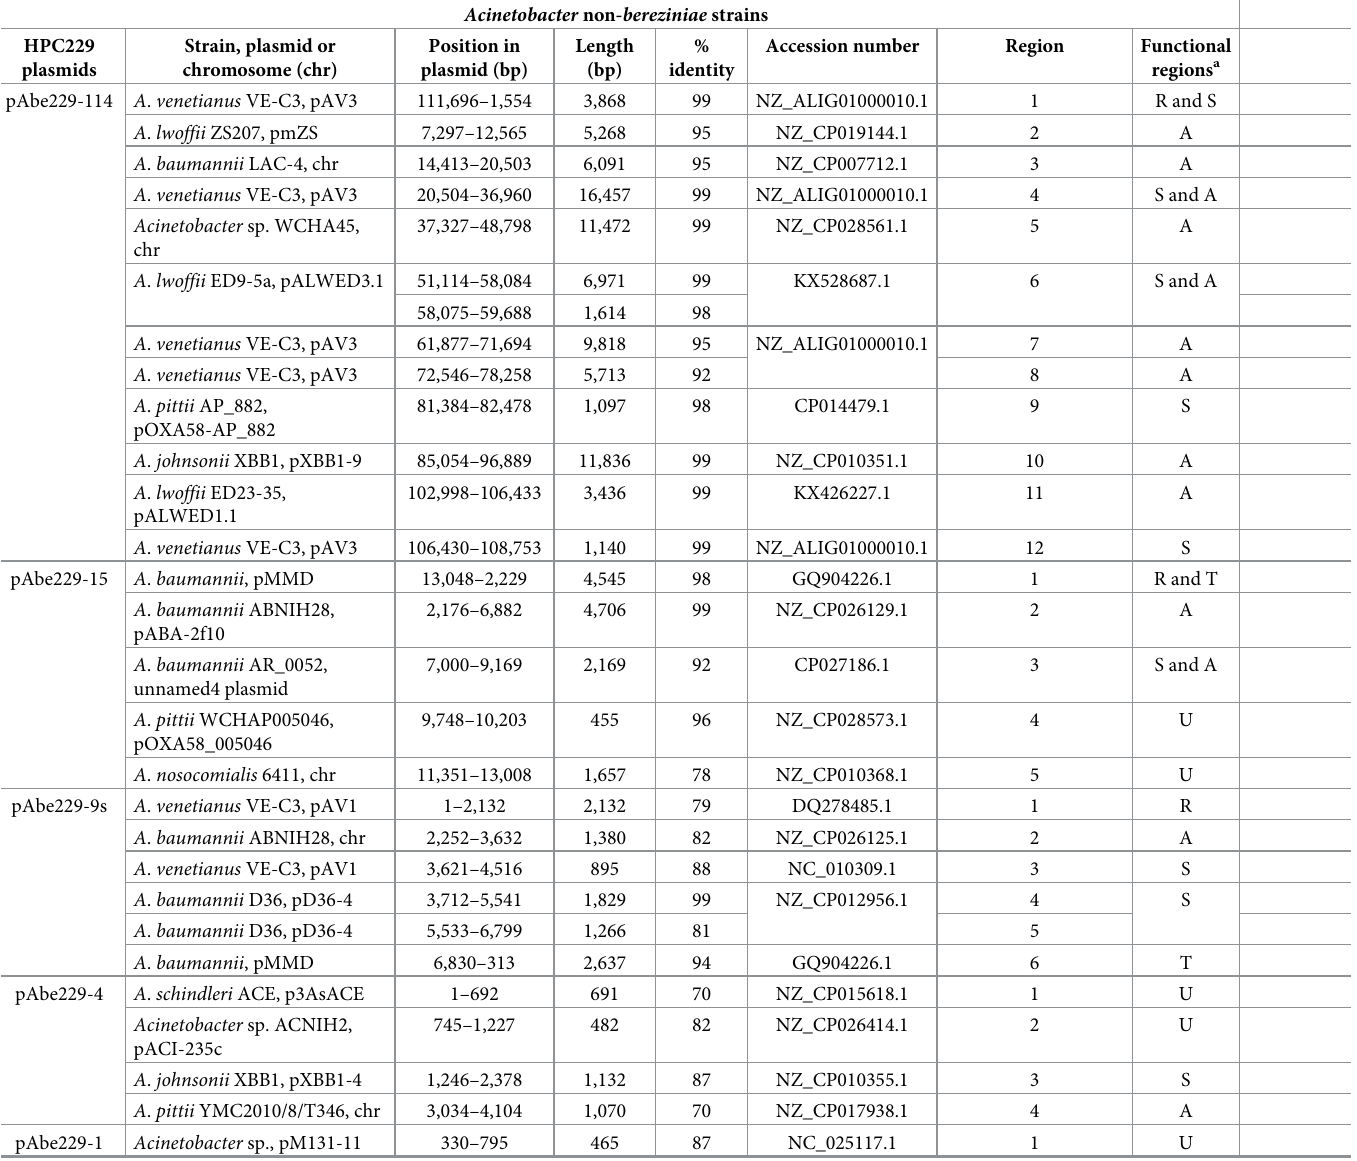
Table 2. Homologous regions in Acinetobacter